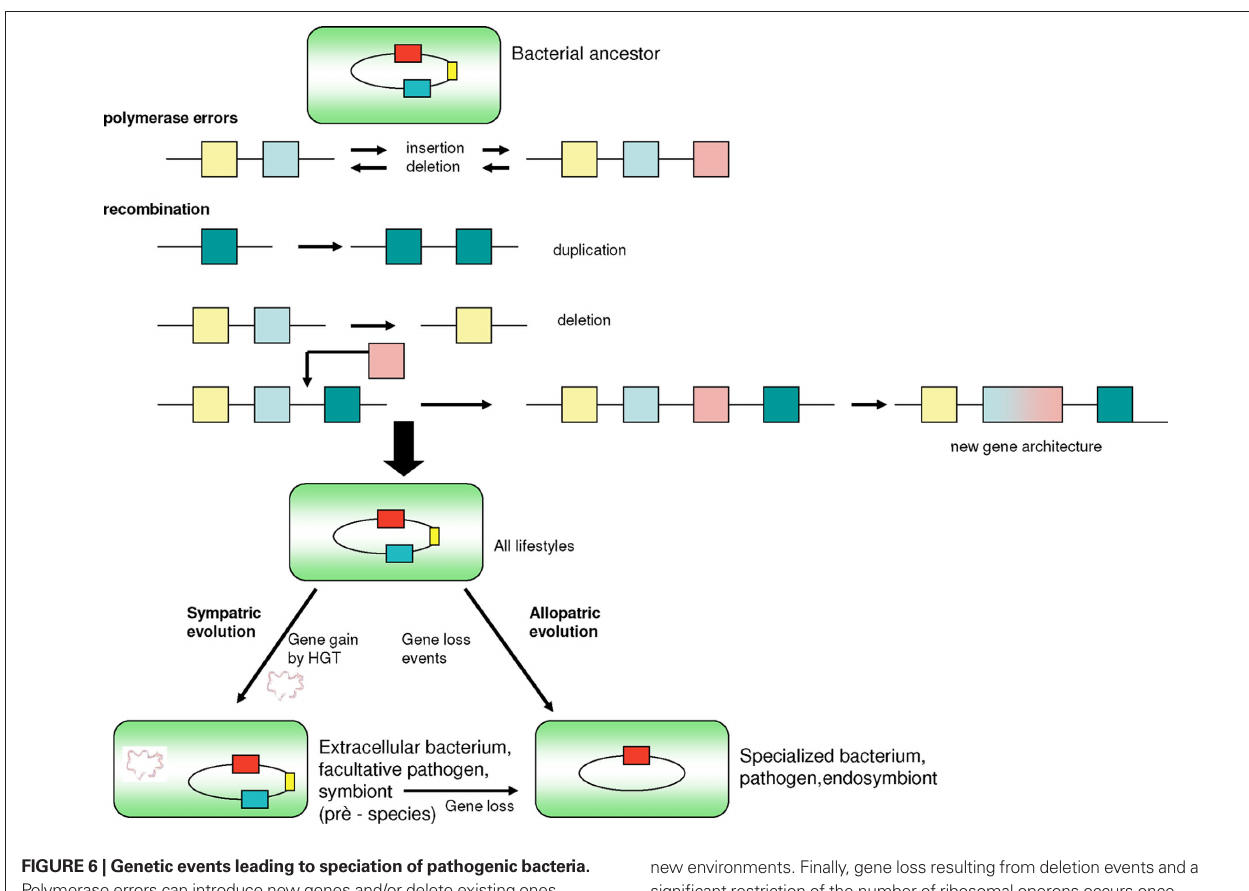
new environments. Finally, gene loss resulting from deletion events and a significant restriction of the number of ribosomal operons occurs once bacteria become specialized in a host organism whose metabolic substrates can be used by bacteria. Gene gain is subsequently